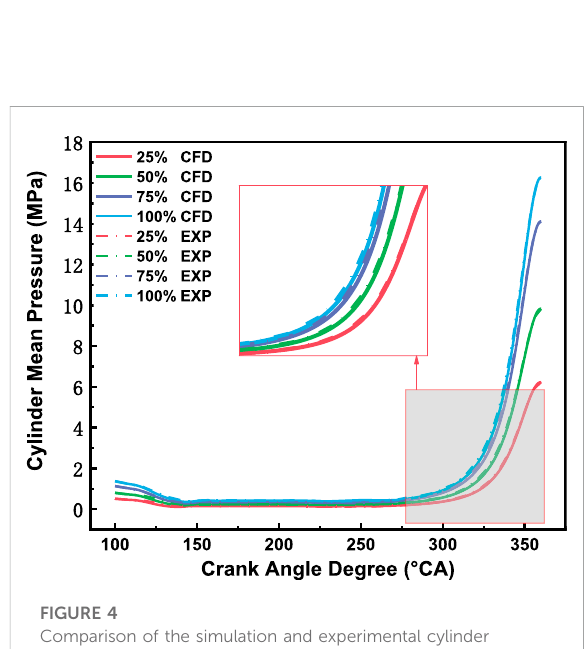
FIGURE 4 Comparison of the simulation and experimental cylinder pressures under different